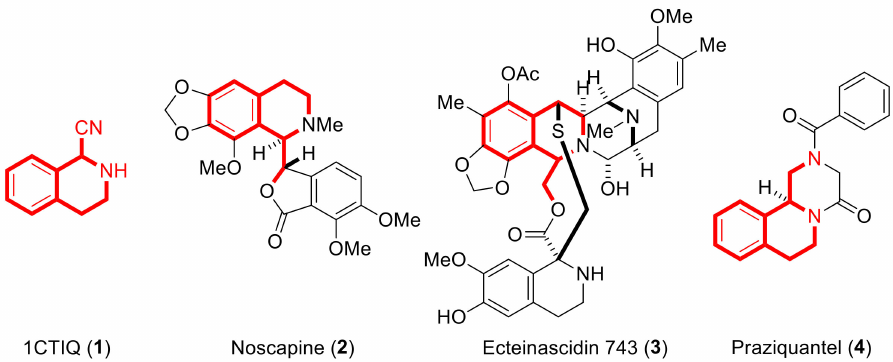
Figure 1. Selected natural products or pharmaceuticals containing α -substituted THIQ